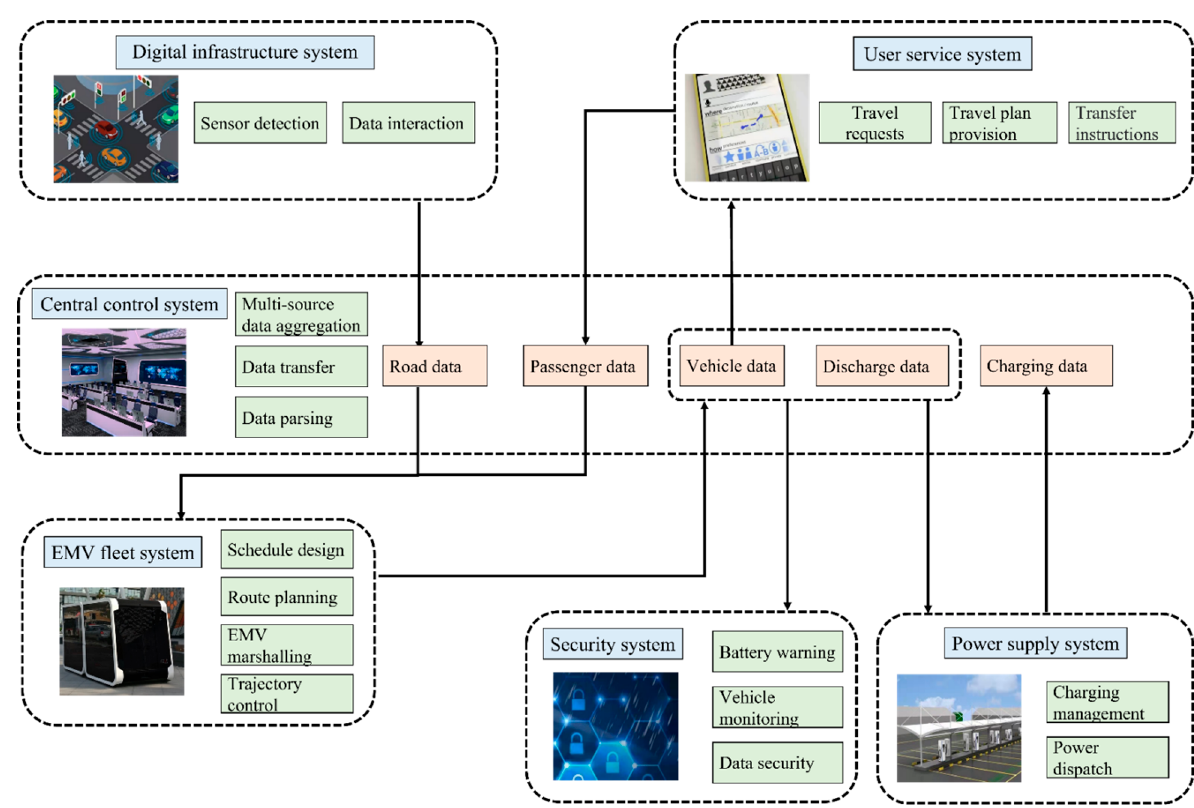
Figure 4. Subsystems’ collaborative fusion for the intelligent platoon transit system.